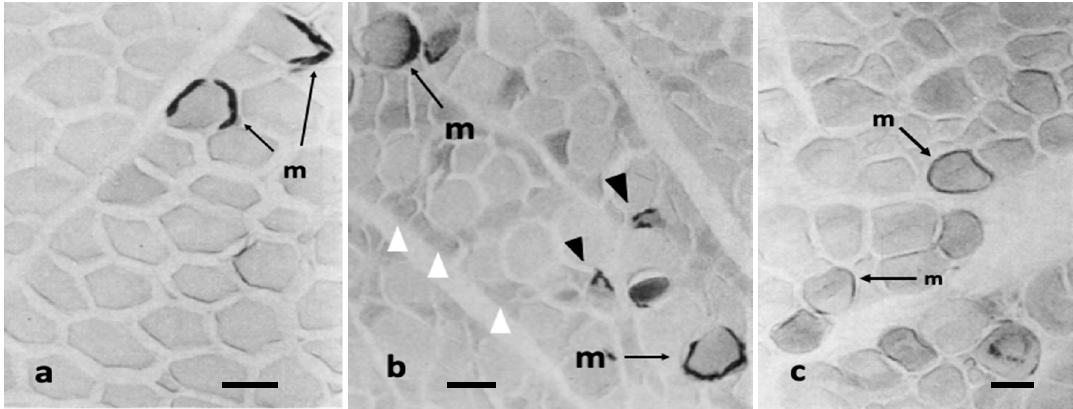
Figure 3. Transverse sections stained for the acetylcholinesterase (AChE) activity with histochemical method at motor endplates (m) of: normal ( a ); heterozygous ( b ); and dystrophic ( c ) pectoralis muscles. The AChE activity in normal pectoralis muscle fibers is confined to the motor endplates, while it extends to the extrajunctional sarcoplasm diffusely in heterozygous and dystrophic fibers. The hypertrophied ⍺ R fibers are surrounded by atrophied ⍺ W fibers (white arrowheads in ( b )), some of which have AChE positive endplates (arrowheads in ( b )). The majority of dystrophic fibers ( c ) are hypertrophy and contain intense AChE activity in sarcoplasm and have motor endplates (m), which are stained weaker and thinner than those in other genotypes. Note a positively stained sarcoplasm, likely “Ring fiber”, at the right lower corner ( c ), Bars = 50 μ m. [17].